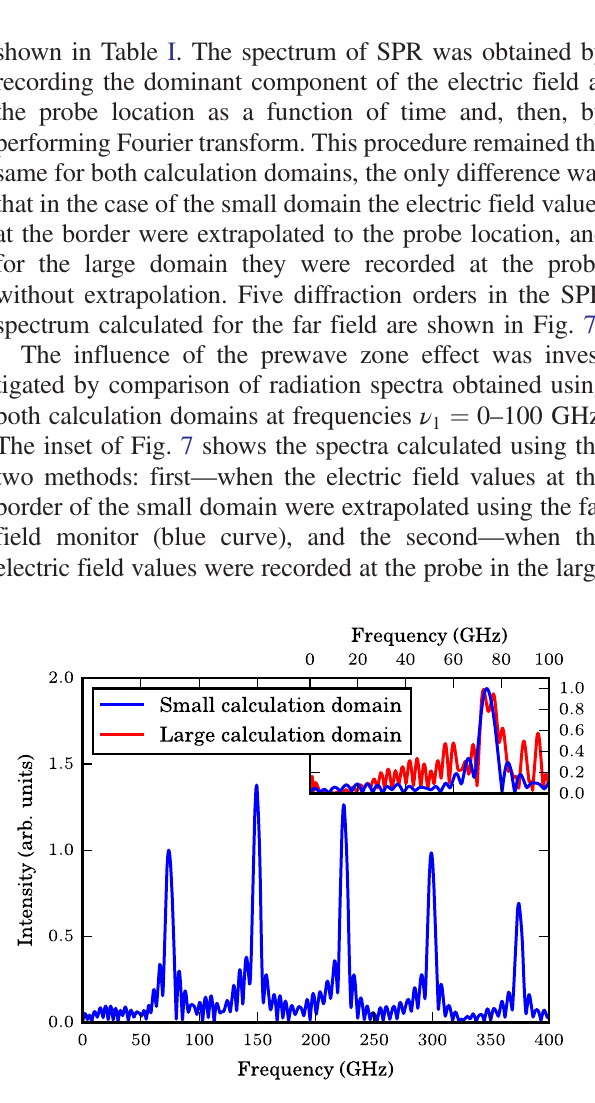
FIG. 6. Electric field representation of beam propagation through small calculation domain near grating.